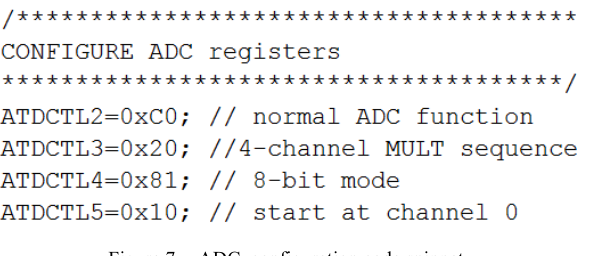
Figure 7. ADC configuration code snippet